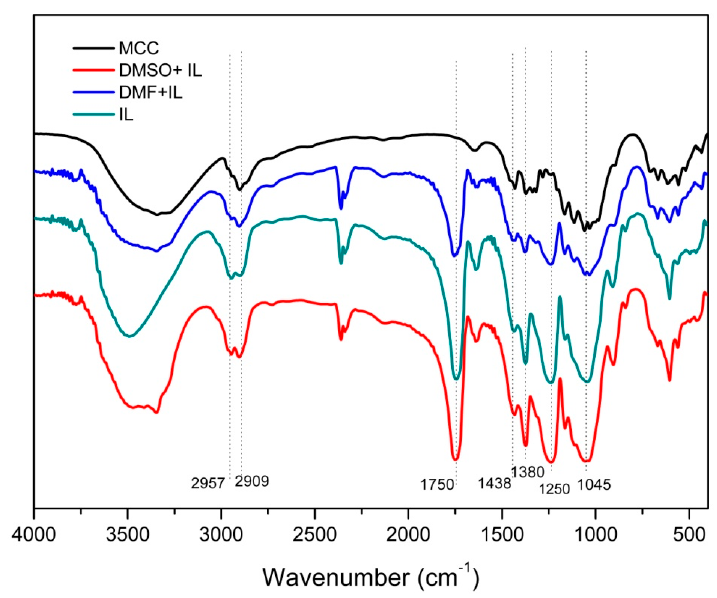
Figure 1. FT-IR spectra of MCC and the prepared CA-5, CA-8 and CA-11 by DBU-catalyzed